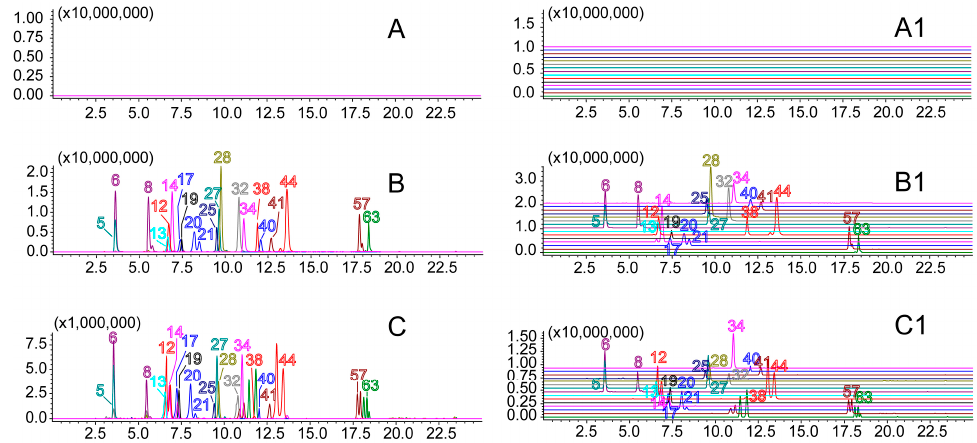
Figure 4. The extracted-ion chromatograms of 21 analytes determined by UFLC-IT-TOF/MS. (( A ) &